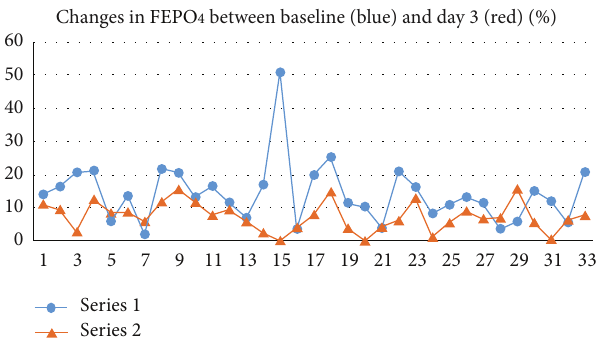
Figure 1: Changes in FEPO4 between baseline and day 3 after